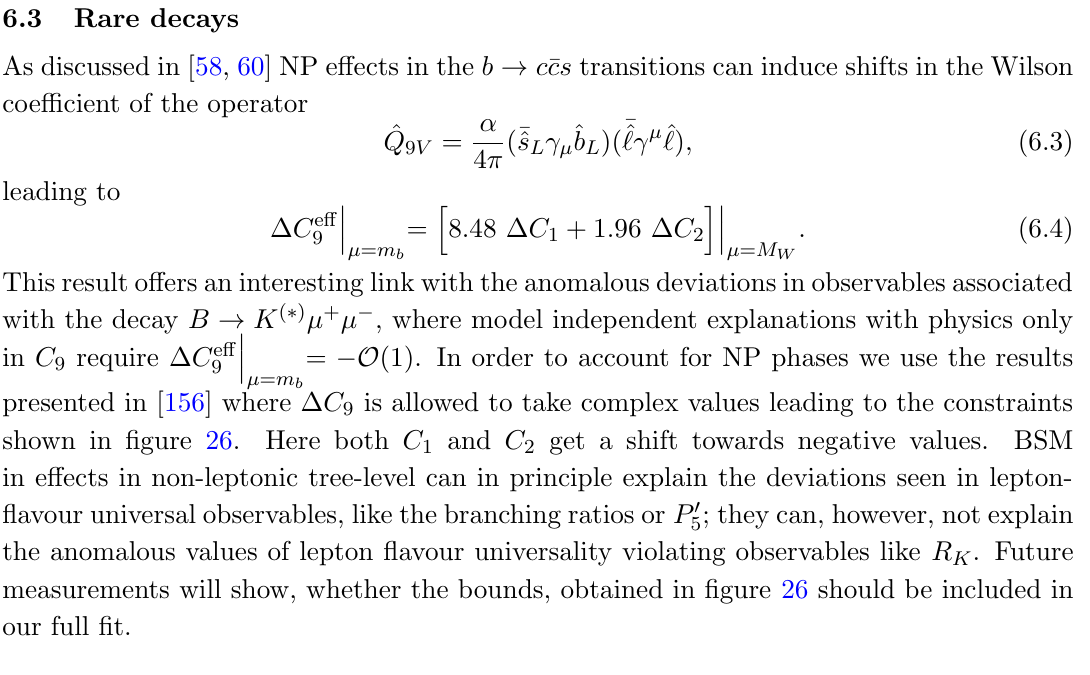
Figure 25 . Future scenarios for the precision in the observable a s (cid:1) C 1 and (cid:1) C 2 . The current uncertainty is expected to be reduced down to 1 per mille and later even to 0.3 per